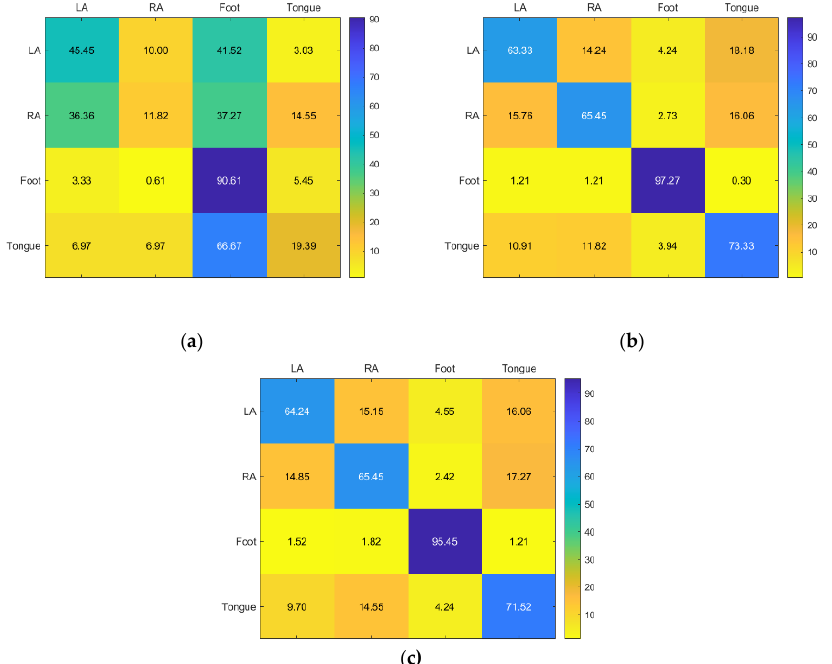
Figure 13. Confusion matrices for the ( a ) KNN, ( b ) SVM, and ( c ) RF classifiers to demonstrate the MI-BCI performance from the seventh subject’s four classes (left hand, right hand, feet, and tongue). KNN has generally good accuracy with foot and tongue for Subject 8. SVM only has good accuracy in foot, whereas RF also achieves acceptable results (Figure 14).